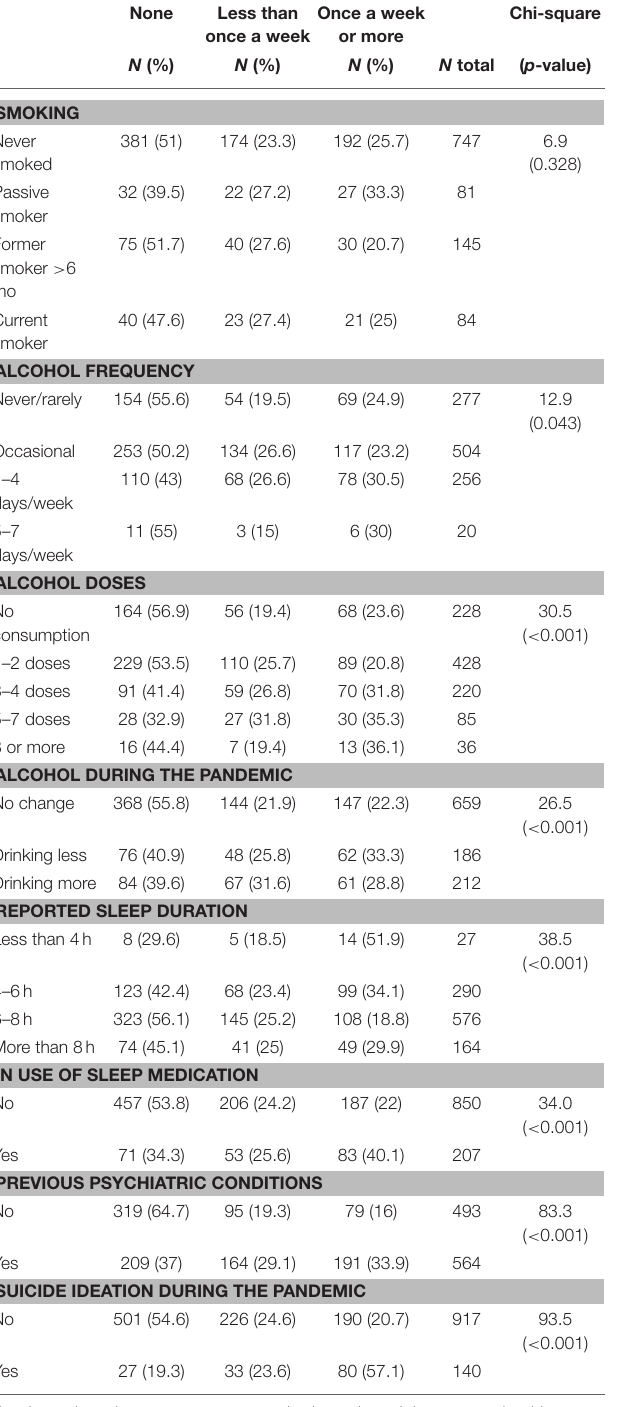
Results are based on non-empty rows and columns in each innermost sub-table. * The Chi-square statistic is significant at the 0.05 level.